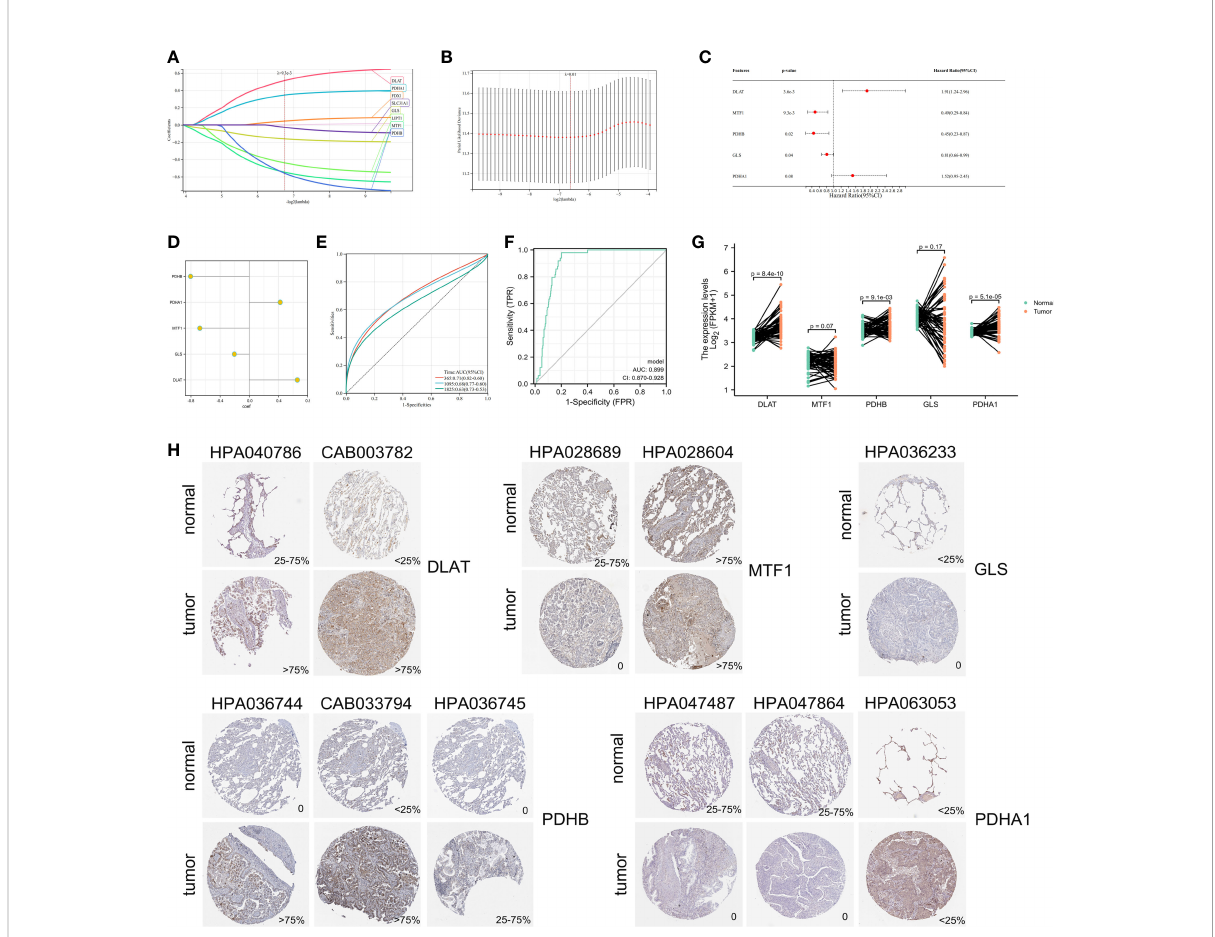
FIGURE 4 Identi fi cation of cuproptosis-related signature via LASSO-stepwise algorithms. (A, B) LASSO analysis with minimal lambda value. (C) Five genes were screen out by stepwise Cox algorithm. (D) Coef fi cients of 5 cuproptosis-related genes fi nally obtained in stepwise Cox regression. (E) The time-dependent ROC curve for Lasso-stepwise signature. (F) The ROC curve for LASSO-stepwise signature. (G) MRNA expression values in paired samples in TCGA. (H) Protein expressions of 5 differentially expressed cuproptosis-related signature in the tumor and normal tissues from the Human Protein Atlas